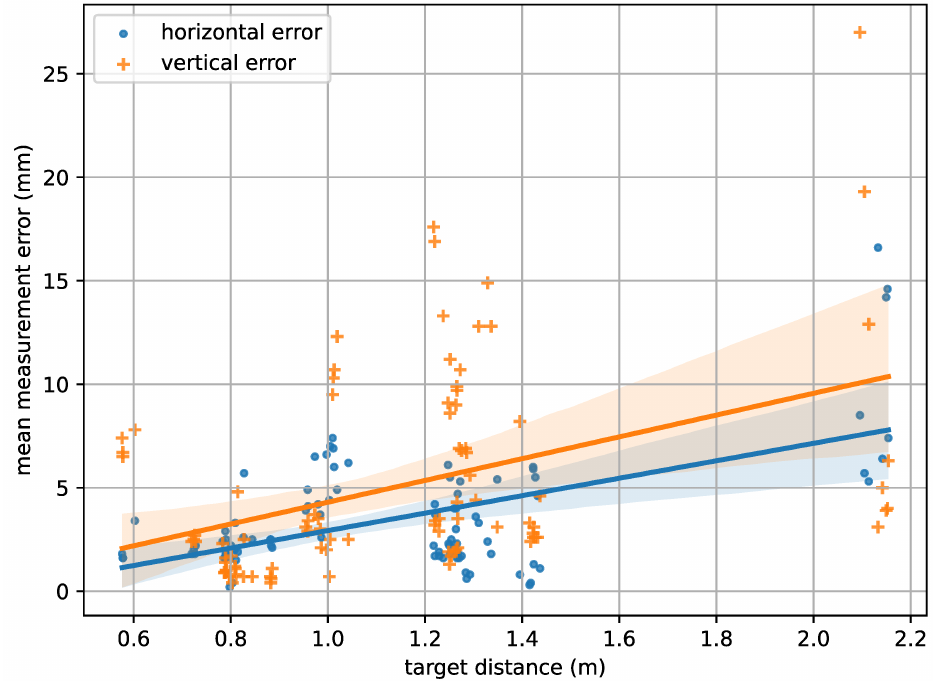
Figure 6. The horizontal and vertical measurement error in relation to the recording distance as has been automatically estimated using a calibration